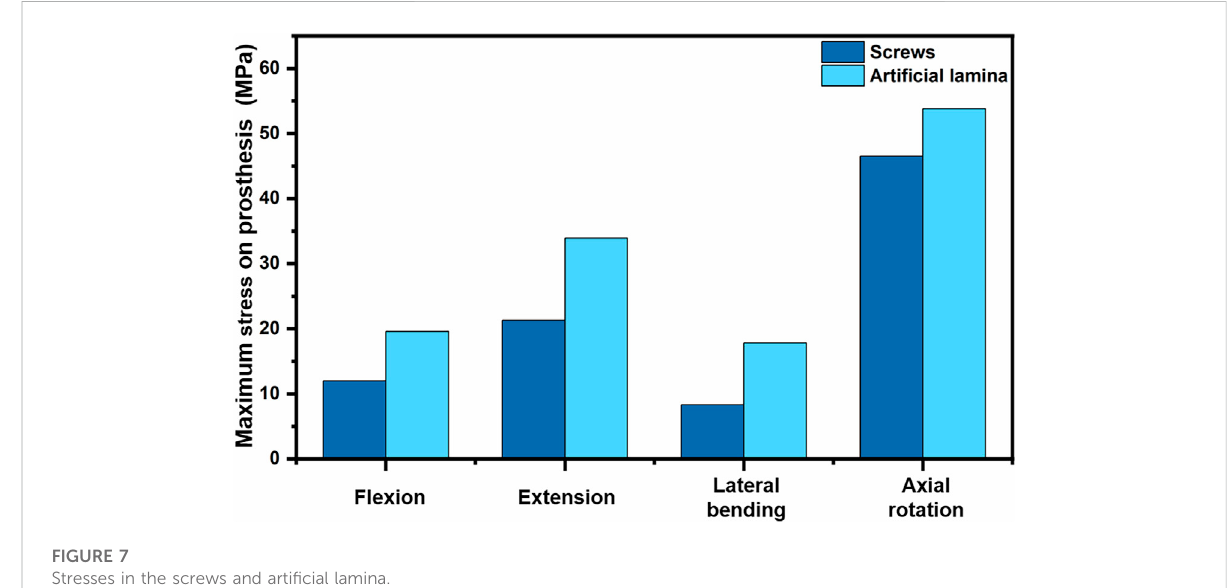
FIGURE 7 Stresses in the screws and arti fi cial lamina.